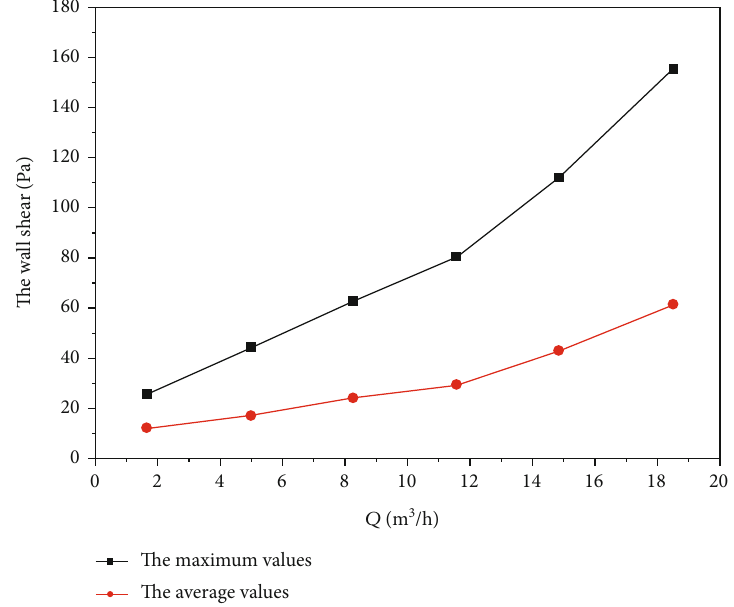
Figure 9: Variation of wall shear with the inlet fl ow